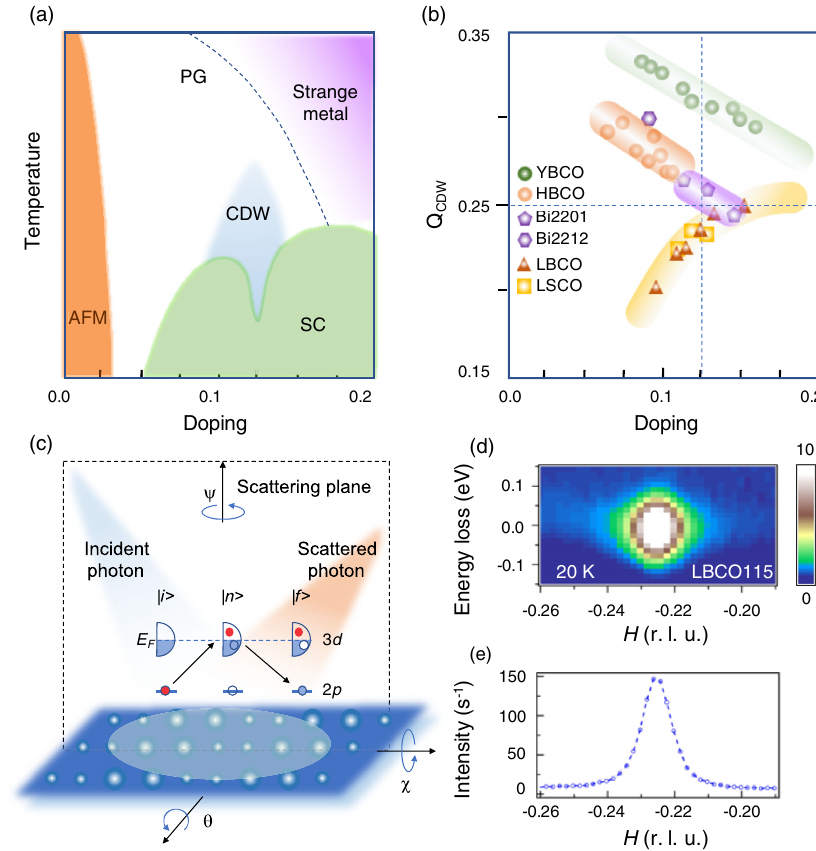
FIG. 1. CDWs in the cuprates. (a) Schematic phase diagram of the cuprates. A ubiquitous CDW dome is observed below the pseudogap temperature and coexists with superconductivity. (b) The doping-dependent CDW wave vector Q in various cuprate CDW families at low temperature [8,10 – 12,16,17,22]. (c) schematically shows the L -edge RIXS process and experimental setup. j i i , j n i , and j f i represent initial, intermediate, and final states, respectively. Solid and empty circles represent occupied and unoccupied states, respectively. (d) Typical RIXS intensity map of La 2 − Ba CuO 4 ( x ¼ 0 . 115 ) at 20 K. The momentum transfer is obtained by rotating the x x sample about the θ or χ axis. (e) The integrated RIXS intensity in a (cid:2) 100 meV energy window of (d) shows a strong CDW peak at Q ¼ 0 . 225 r : l : u : CDW